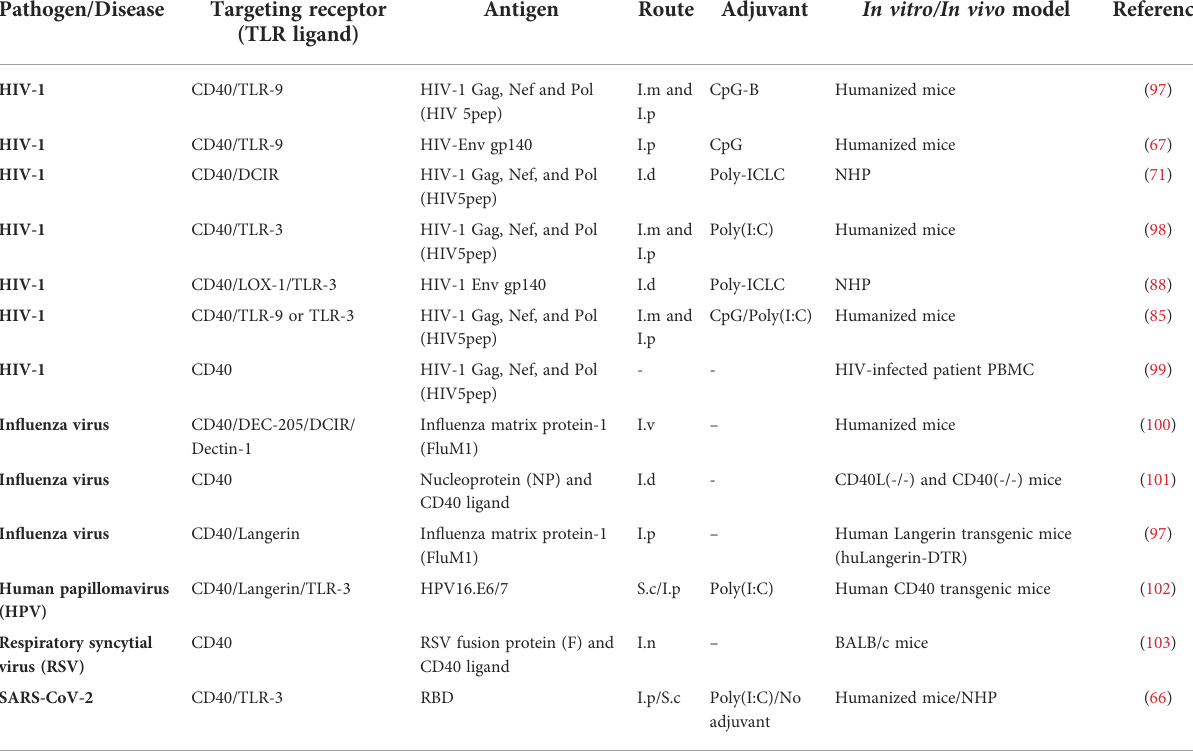
TABLE 1 Anti-CD40 targeting vaccines currently in development against infectious diseases.